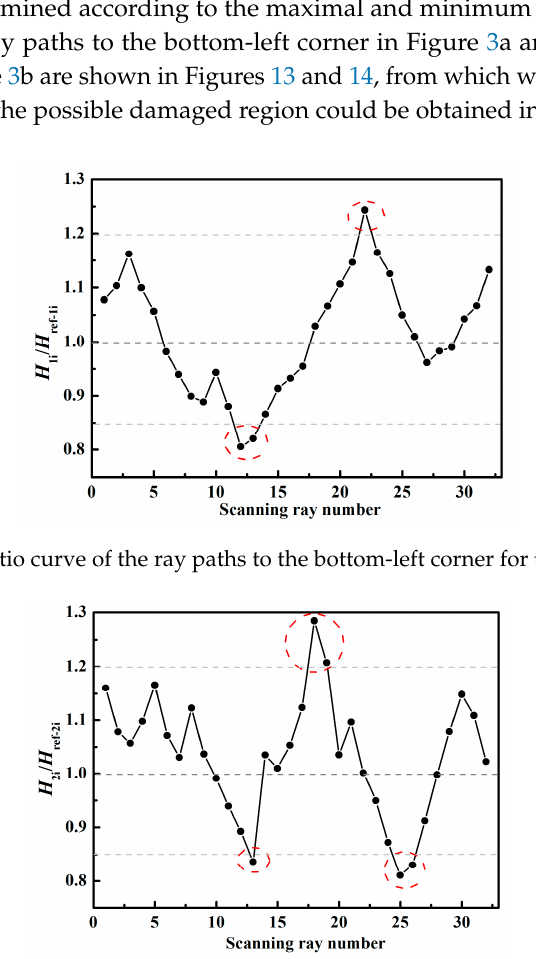
Figure 14. Ratio curve of the ray paths to the upper-left corner for the front side.